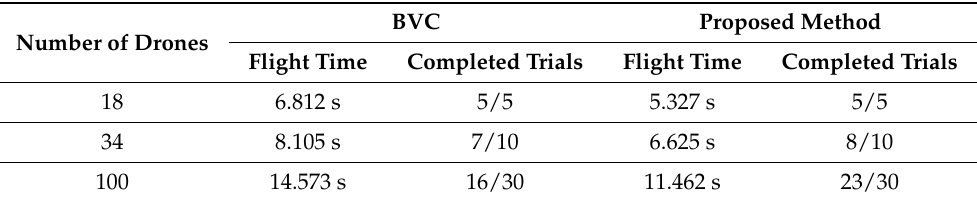
Figure 9. Collision − free trajectories for 100 drones flying from their initial positions (dots) to randomly specified final positions (squares) at different replanning steps. Table 1. Comparing the number of successful trials and the average flight time achieved with the BVC and the proposed method in the paper.